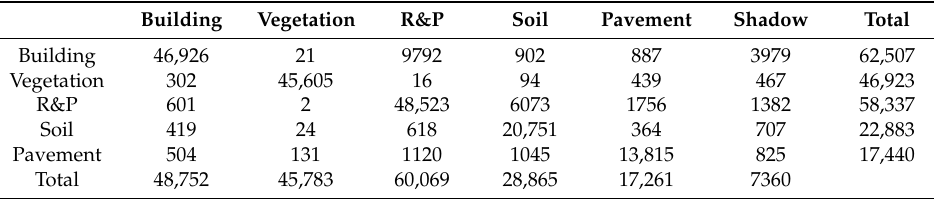
Table 5. Confusion matrix of the joint classification map, where the reference is shown as Figure 15. The values in the table indicate the numbers of